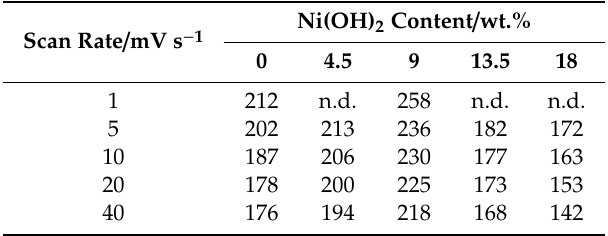
Table 1. Specific capacitance (F g − 1 ) of electrode material with di ff erent theoretical Ni(OH) 2 contents calculated from cyclic voltammetry (CV) curves. n.d.—not determined.